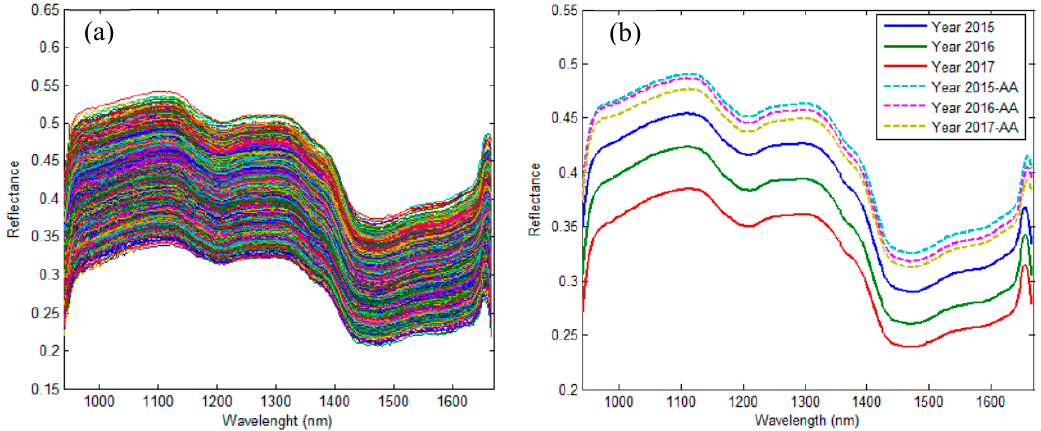
Figure 1. ( a ) Raw spectra of all rice simples and ( b ) mean spectra for rice seeds. Table 1. Germination rate and vitality index of all sets of seeds as determined by germination test.